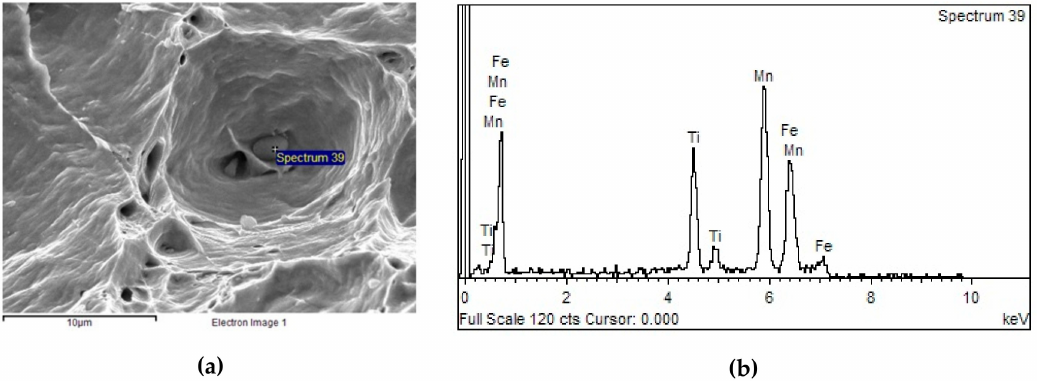
Figure 8. ( a ) Particles on the fracture, sample X5, T Q = 847 ◦ C, N f = 424.1; ( b ) EDX spectrum from the particle in Figure 8a-Fe, Ti,